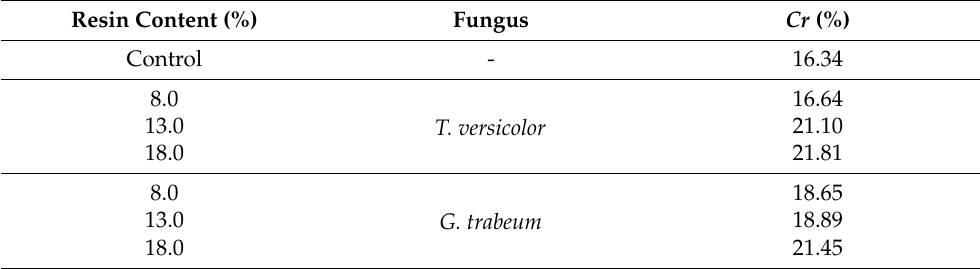
Table 3. Crystallinity ( Cr ) of healthy (control) and decayed OWMECs with different resin contents. Table 4. Crystallinity ( Cr ) of healthy (control) and decayed OWMECs with different densities. Resin Content (%) Density (g/cm 3